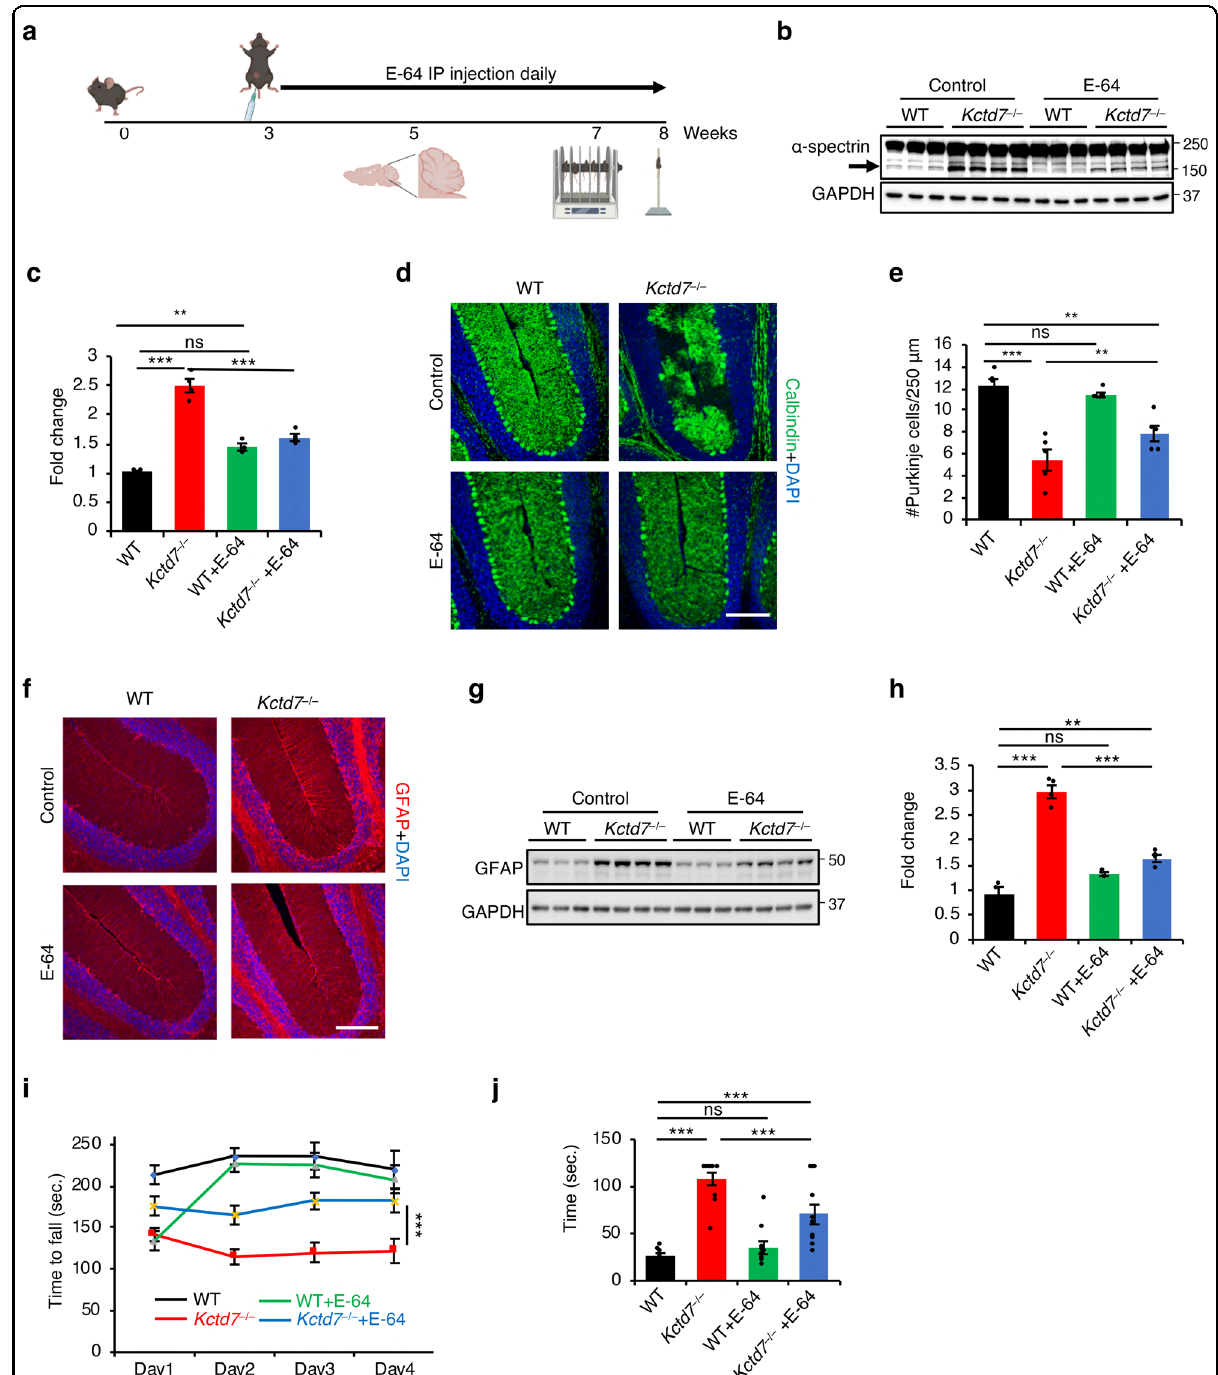
Fig. 8 Calpain inhibition in Kctd7 – / – mice ameliorates behavioral impairments and neurodegeneration. a Schematic diagram of drug treatment, tissue preparation and behavioral tests. b , c Immunoblot analysis of cerebellar tissue from 8-week-old WT and Kctd7 – / – mice treated with E-64 or vehicle using α -spectrin antibody, n = 3 for WT (untreated and treated), n = 4 for Kctd7 – / – (untreated and treated). d – f Confocal microscopy analysis of the cerebellum from 8-week-old WT and Kctd7 – / – mice treated with E-64 or vehicle. α -calbindin antibody and α -GFAP antibody were used to label Purkinje cells ( d ) and astrocytes ( f ), respectively. Scale bars, 200 μ m. Quantitation of Purkinje cell numbers is reported in e , n = 5. g , h Immunoblot analysis of cerebellar tissue from 8-week-old WT and Kctd7 – / – mice treated with E-64 or vehicle using α -GFAP antibody, n = 3 for WT (untreated and treated), n = 4 for Kctd7 – / – (untreated and treated). i Rotarod test measuring the latency to fall for 8-week-old WT and Kctd7 – / – mice treated with E-64 or vehicle. n = 10 for vehicle-treated mice (WT and Kctd7 – / – ). n = 12 for E-64-treated mice (WT and Kctd7 – / – ). j Inverted pole test measuring the time used to climb down from the pole for 8-week-old WT and Kctd7 – / – mice treated with E-64 or vehicle. n = 10 for vehicle-treated mice (WT and Kctd7 – / – ). n = 12 for E-64-treated mice (WT and Kctd7 – / – ); ∗ P <0.05, ∗∗ P <0.01, ∗∗∗ P <0.001, ns not signi fi